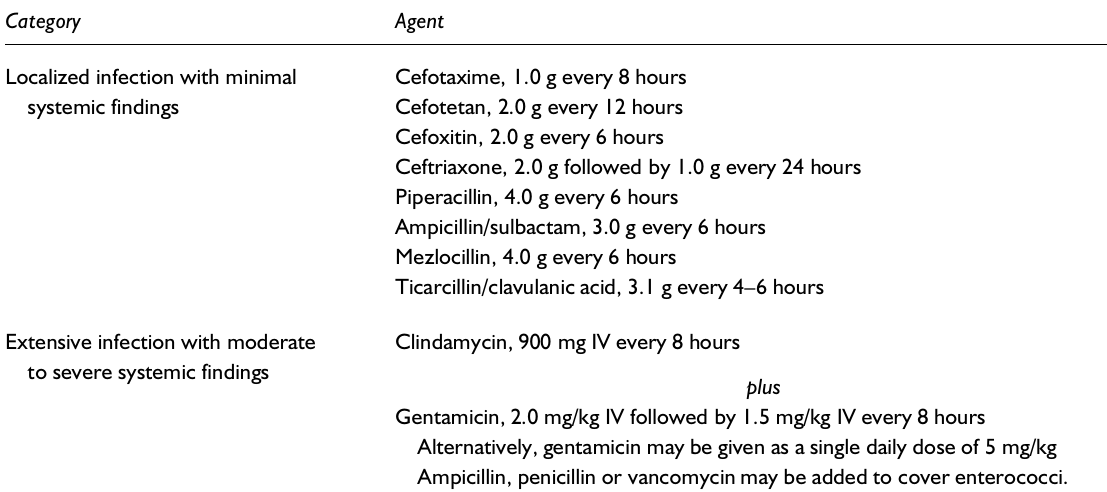
Table 1 Intravenous antibiotic regimens for treating postoperative